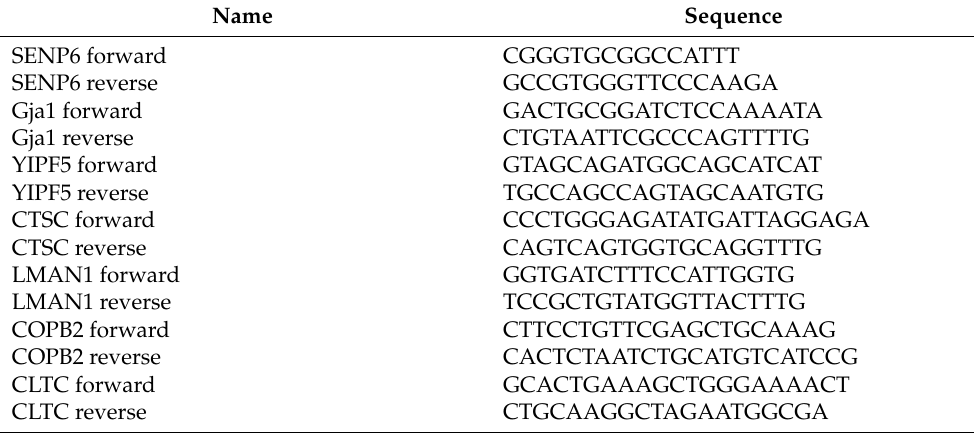
Table 1. The primer sequences in this study (5 (cid:48) → 3 (cid:48)